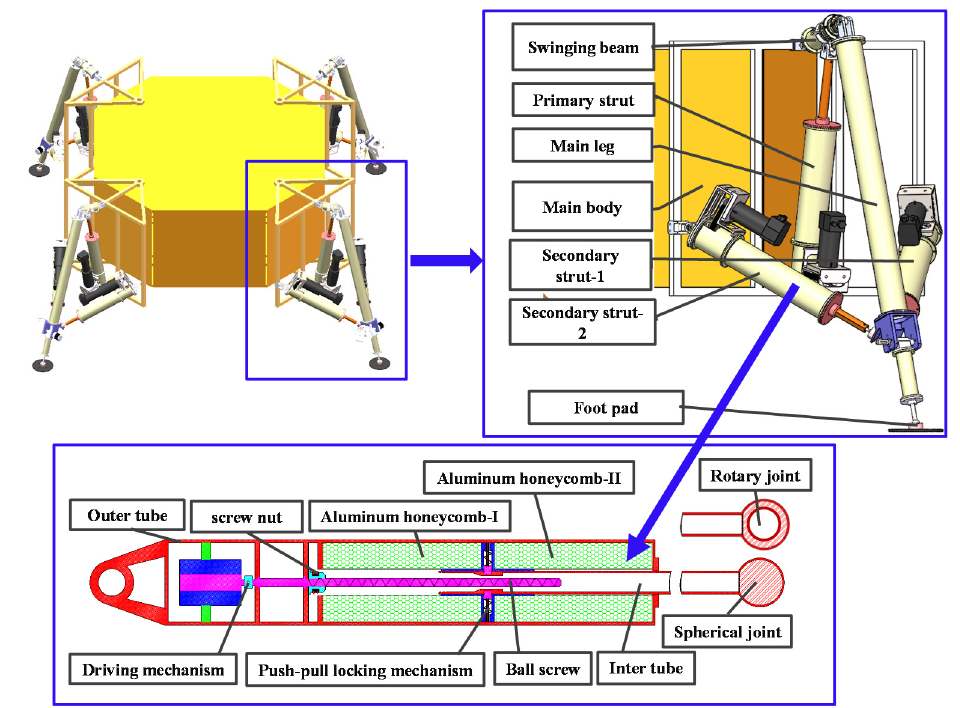
Figure 1. Geometrical description of the movable lander (ML).